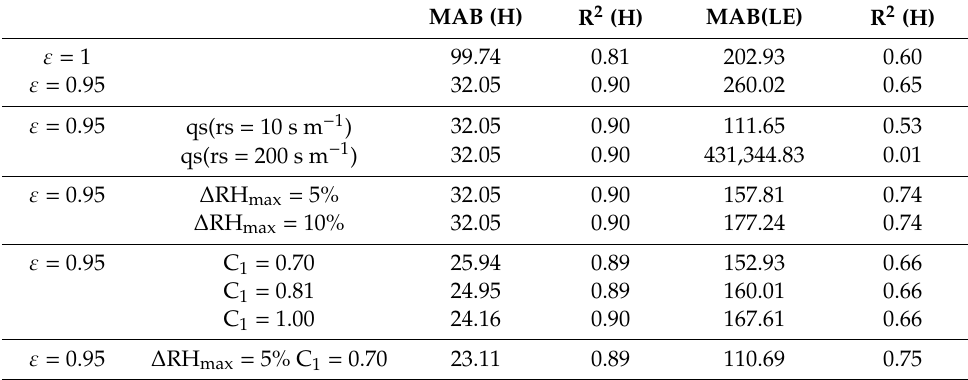
Table 1. Summary of the results for the di ff erent alternatives of the assumptions made for the application of the bulk method. MAB (Mean Absolute Bias) is in W m − 2